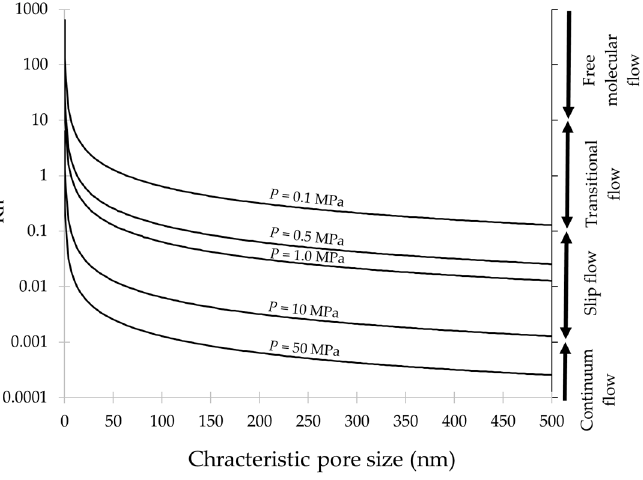
Figure 1. Kn (see Equations (8) and (9)) as a function of pore size and